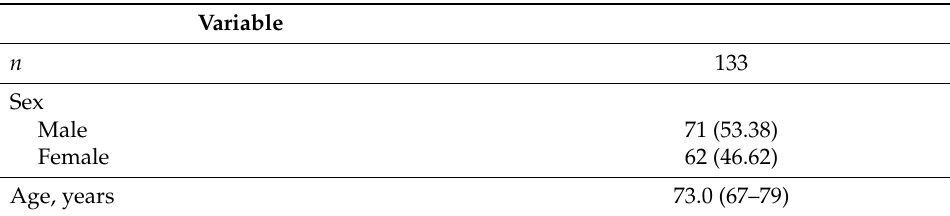
Table 1. General characteristics of all study